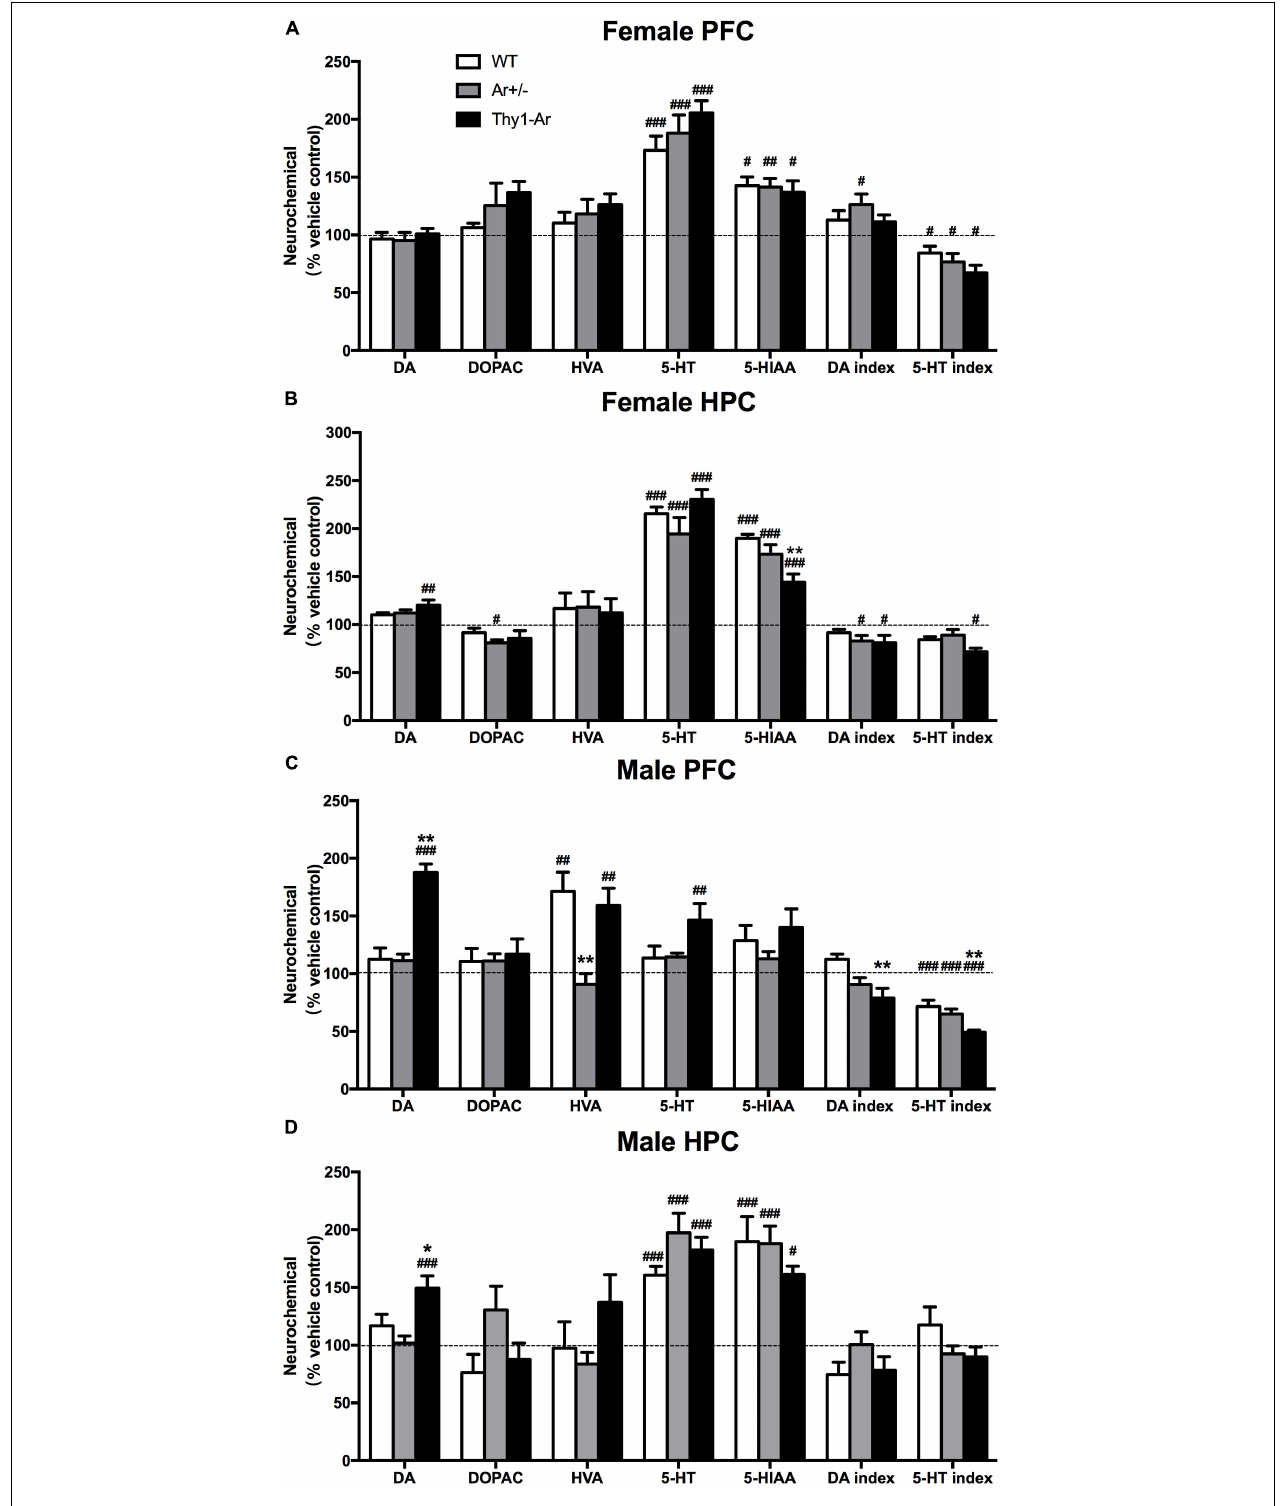
FIGURE 4 | Sex- and brain region- specific differences in DA and 5-TH systems following sertraline administration. The percentage of DA and 5-TH related neurotransmitters for sertraline-treated and vehicle-treated in (A) female PFC, (B) female HPC, (C) male PFC, and (D) male HPC. Data represent means ± SEM ( N = 6–7 mice/group), as evidenced by the two-way ANOVA followed by Bonferroni post hoc test. # P < 0.05, ## P < 0.01, ### P < 0.001 versus vehicle group; ∗ P < 0.05, ∗∗ P < 0.01 versus WT mice.